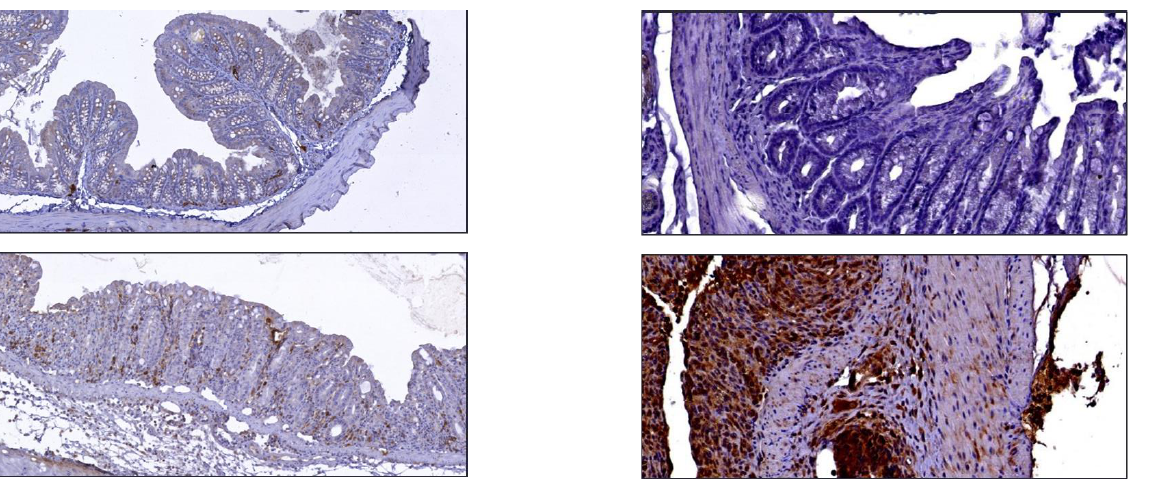
Figure 1. Anti- α 4 β 7 integrin ( left , 10 × ) and anti-TNF α ( right , 20 × ) IHC staining of colon in control mice ( top ) vs. DSS mice ( bottom ).